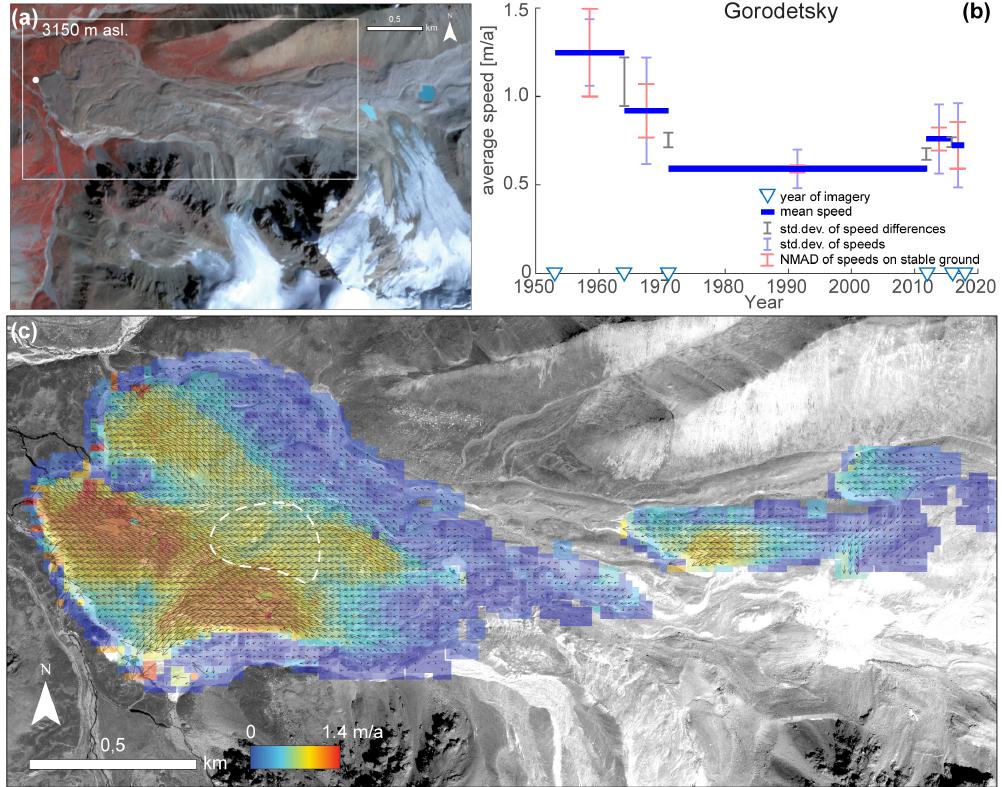
Figure 3. Velocities and speed variations on the Gorodetsky rock glacier. (a) Overview image; © Planet image on 7 September 2016 in near-infrared–red–green R–G–B composition. (b) Average time series of speeds for a cluster of points (white dashed outline in panel c ). Error bars give normalized median absolute deviations (NMADs) of stable ground speeds (red), standard deviations of speeds within the point cluster (blue), and standard deviations of speed differences within the measurement periods (grey) in m/a. Blue triangles on the time axis indicate years of imagery used. (c) Colour-coded velocity field with vectors superimposed from image matching between 2012 and 2016 high-resolution satellite images (for exact dates and sensors see Table S2). Background image: Pléiades, 27 August 2016 © CNES (2016), and Airbus DS